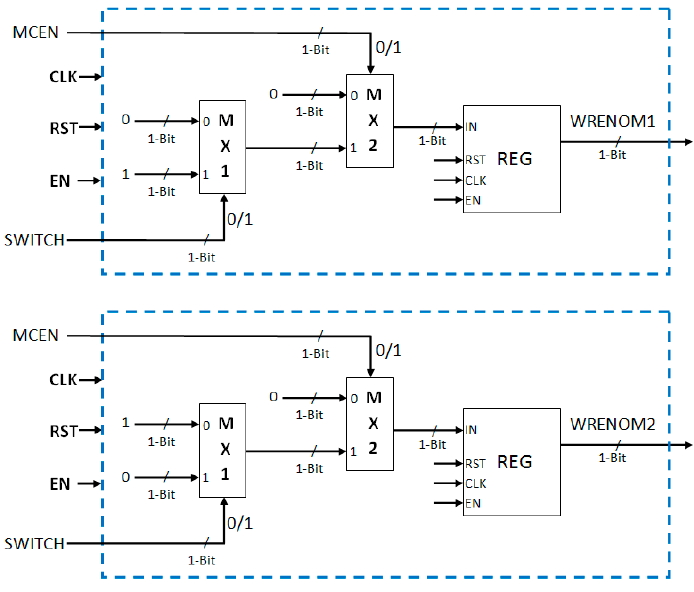
Figure 19. Write enable signal generation logic for two output memories.